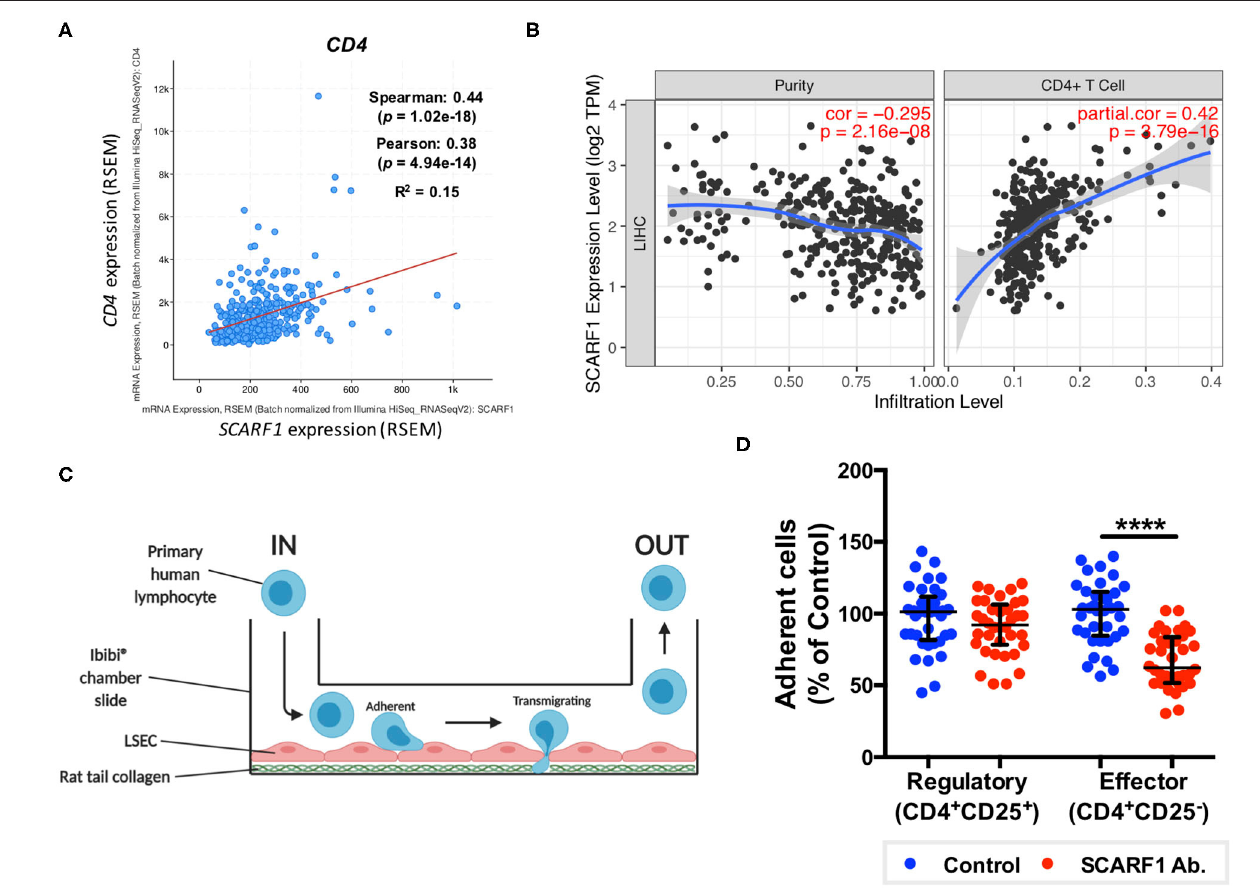
FIGURE 5 | SCARF1 potentially mediates the recruitment of proinflammatory CD4 + T cells to HCC tumors. (A) Correlation of SCARF1 expression with CD4 expression in HCC tumor tissues. n = 358. (B) Correlation of SCARF1 expression with the extent of CD4 + T cell infiltration in HCC tumor tissues. n = 358. (C) Schematic representation of a flow-based adhesion assay with primary human lymphocytes flowed across primary human LSEC. (D) Quantification of percentage of adherent CD4 + T cell subsets [regulatory (CD4 + CD25 + ) and effector (CD4 + CD25 − )] in the presence of SCARF1 blocking antibody or isotype-matched control (Control) antibody. **** indicates statistical significance as measured by a paired T -test, where p ≤ 0.001. n = 3 independent experiments with different LSEC and lymphocyte donors, with 12 fields of view taken from each. Data in (B) was generated with use of Tumor IMmune Estimation Resource (TIMER; https://cistrome. shinyapps.io/timer/; accessed 12th May 2020). Image in (C) created with BioRender.com.